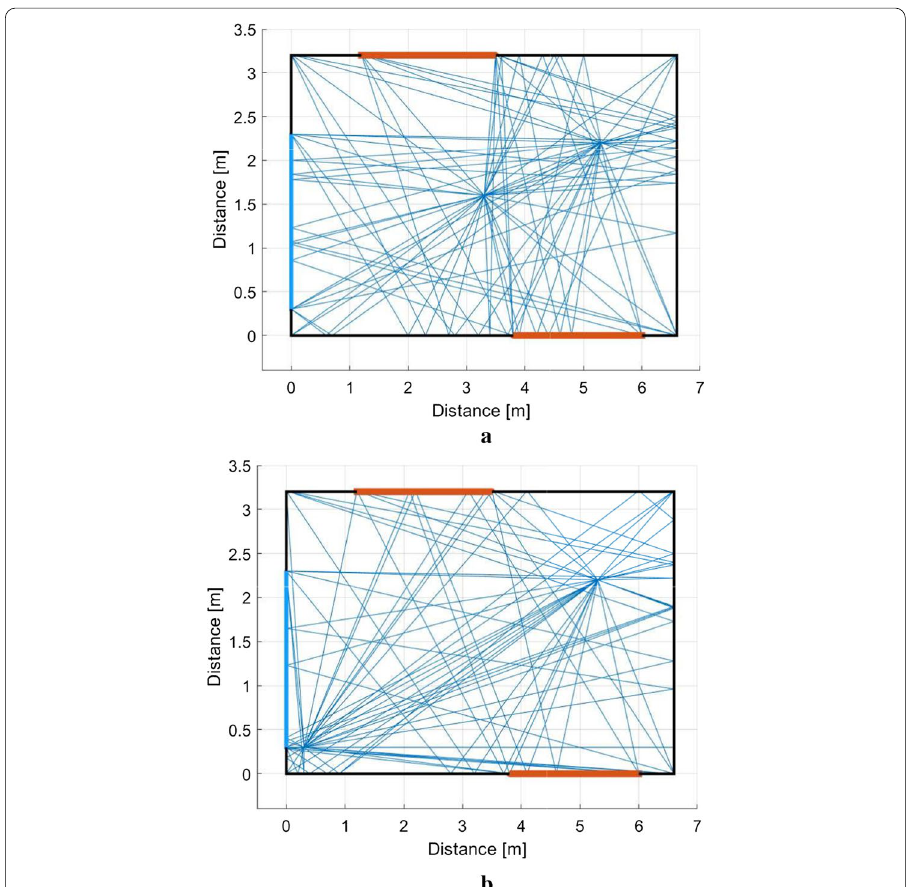
Fig. 4 Propagation paths obtained through ray tracing for position 10 with, a Tx1, and b